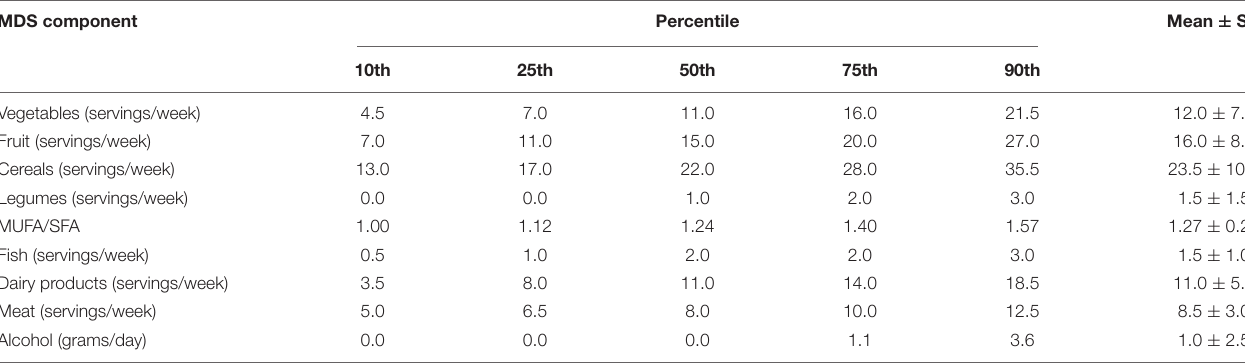
TABLE 2 | Distribution of components of the Mediterranean Diet Score. MDS component